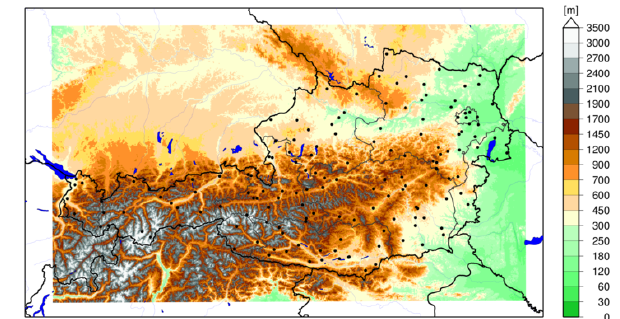
Figure 1. Operational INCA domain. Stations used in the evalua- tion are marked as black dots.